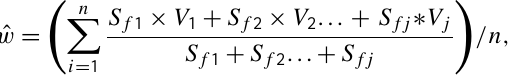
Table 2. Variables and ranges used to characterize herbaceous